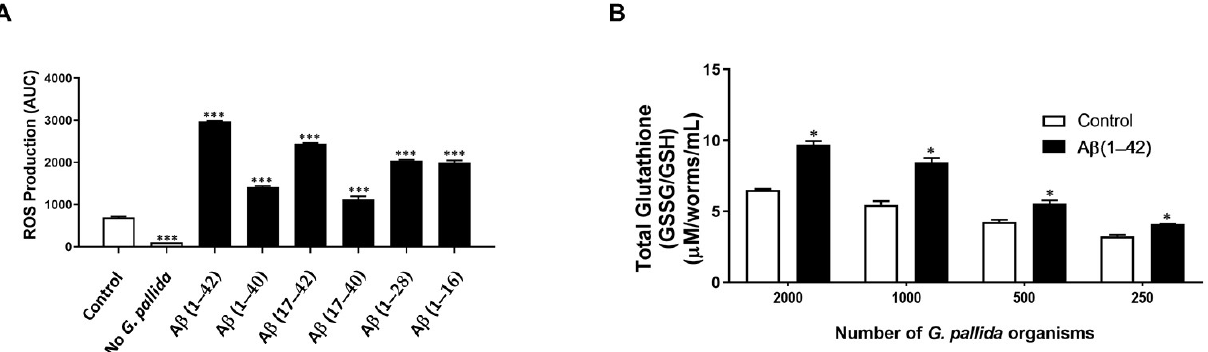
Figure 4. Changes in oxidative stress in G. pallida in response to amyloid- β (A β ) peptide fragments. Total ROS production was determined by adding 2 ′ ,7 ′ -dichlorofluorescin diacetate (DCFH-DA) and measuring fluorescence every 30 min for 24 h (Ex: 485 nm, Em: 520 nm, FLUOstar Omega) at RT. ( A ) ROS production for 0–24 h (s) as measured by AUC analysis. A β (1–42) increased oxidative stress by the greatest extent; ( B ) Effects of amyloid- β (A β ) (1–42) on glutathione levels in G. pallida. The ratio of GSSG to GSH in cells is a measure of cellular oxidative stress. An OxiSelect™ Total Glutathione (GSSG/GSH) Assay kit (Cell Biolabs, Inc., San Diego, CA, USA) was used for measurements. Treatment of either 250, 500, 1000, or 2000 G. pallida second-stage juveniles (J2s) with A β (1–42) led to significantly higher GSSG/GSH compared with control. The data for ( A ) are mean ± SEM ( n = 3) with approximately 100 G. pallida organisms per observation; *** p < 0.001, compared with control group. The data for ( B ) are mean ± SEM ( n = 3); * p < 0.05, compared with control.